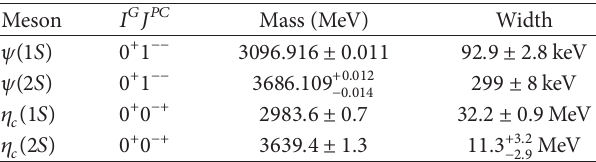
Table 1: The properties of 𝜓(1𝑆,2𝑆) and 𝜂 𝑐 (1𝑆,2𝑆) mesons [12].